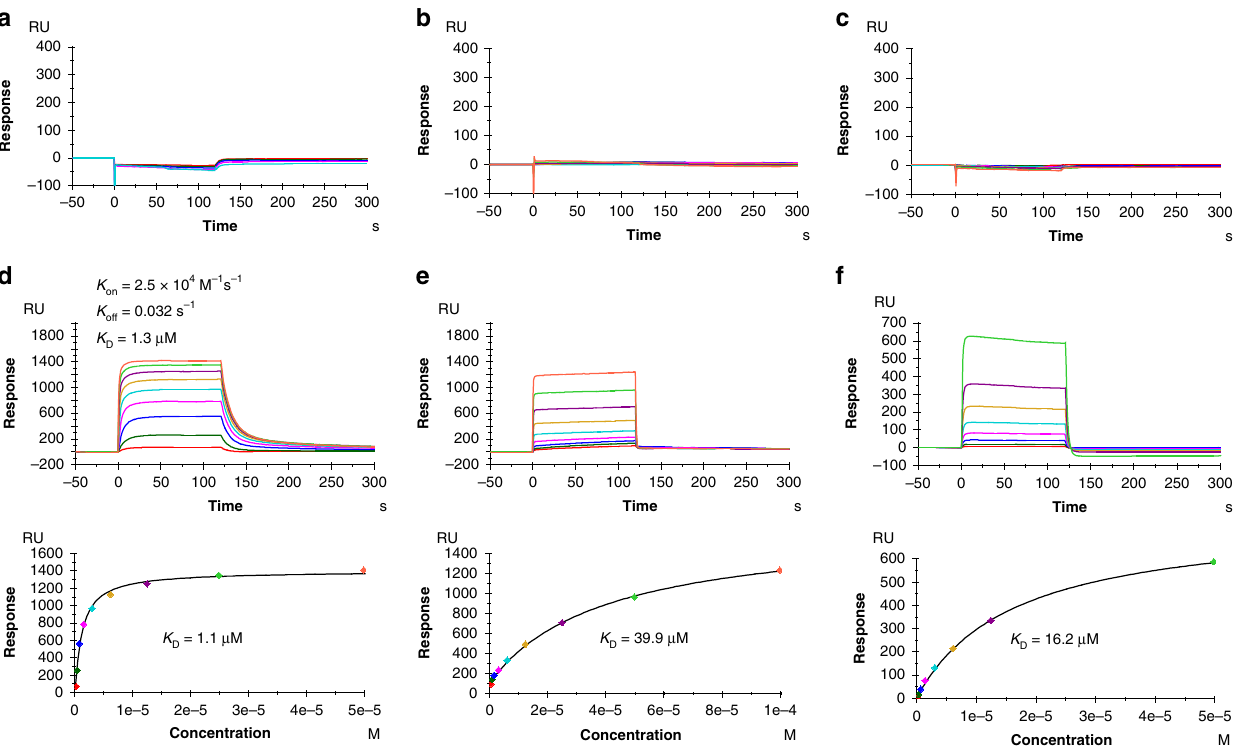
Fig. 1 SPR analysis of TCR binding to p53 – HLA-A2 and p53R175H – HLA-A2. a TCR 12-6 at concentrations of 20.5, 41, 82, 164, and 328 μ M was injected over immobilized p53 – HLA-A2 (3000 RU). b TCR 38-10 at concentrations of 0.9, 1.8, 3.6, 7.3, 14.5, 29, 58, 116, and 232 μ M was injected over immobilized p53 – HLA-A2. c TCR 1a2 at concentrations of 0.6, 1.2, 2.4, 4.8, 9.6, 19.1, 38.3, 76.5, and 153 μ M was injected over immobilized p53 – HLA-A2. d (upper) TCR 12-6 at concentrations of 0.19, 0.39, 0.78, 1.56, 3.12, 6.25, 12.5, 25, and 50 μ M was injected over immobilized p53R175H – HLA-A2 (3000 RU). (lower) Fitting curve for equilibrium binding that resulted in a K D of 1.1 μ M. e (upper) TCR 38-10 at concentrations of 0.39, 0.78, 1.56, 3.12, 6.25, 12.5, 25, 50.0, and 100 μ M was injected over immobilized p53R175H – HLA-A2. (lower) Fitting curve for equilibrium binding that resulted in a K D of 39.9 μ M. f (upper) TCR 1a2 at concentrations of 0.19, 0.39, 0.78, 1.56, 3.12, 6.25, 12.5, and 50 μ M was injected over immobilized p53R175H – HLA-A2. (lower) Fitting curve for equilibrium binding that resulted in a K D of 16.2 μ M. Source data are provided in a Source data fi ( K D > 100 μ M) 19 . Kinetic parameters (on- and off-rates) for the binding of TCR 12-6 to p53R175H – HLA-A2 were k on = 2.5 ×